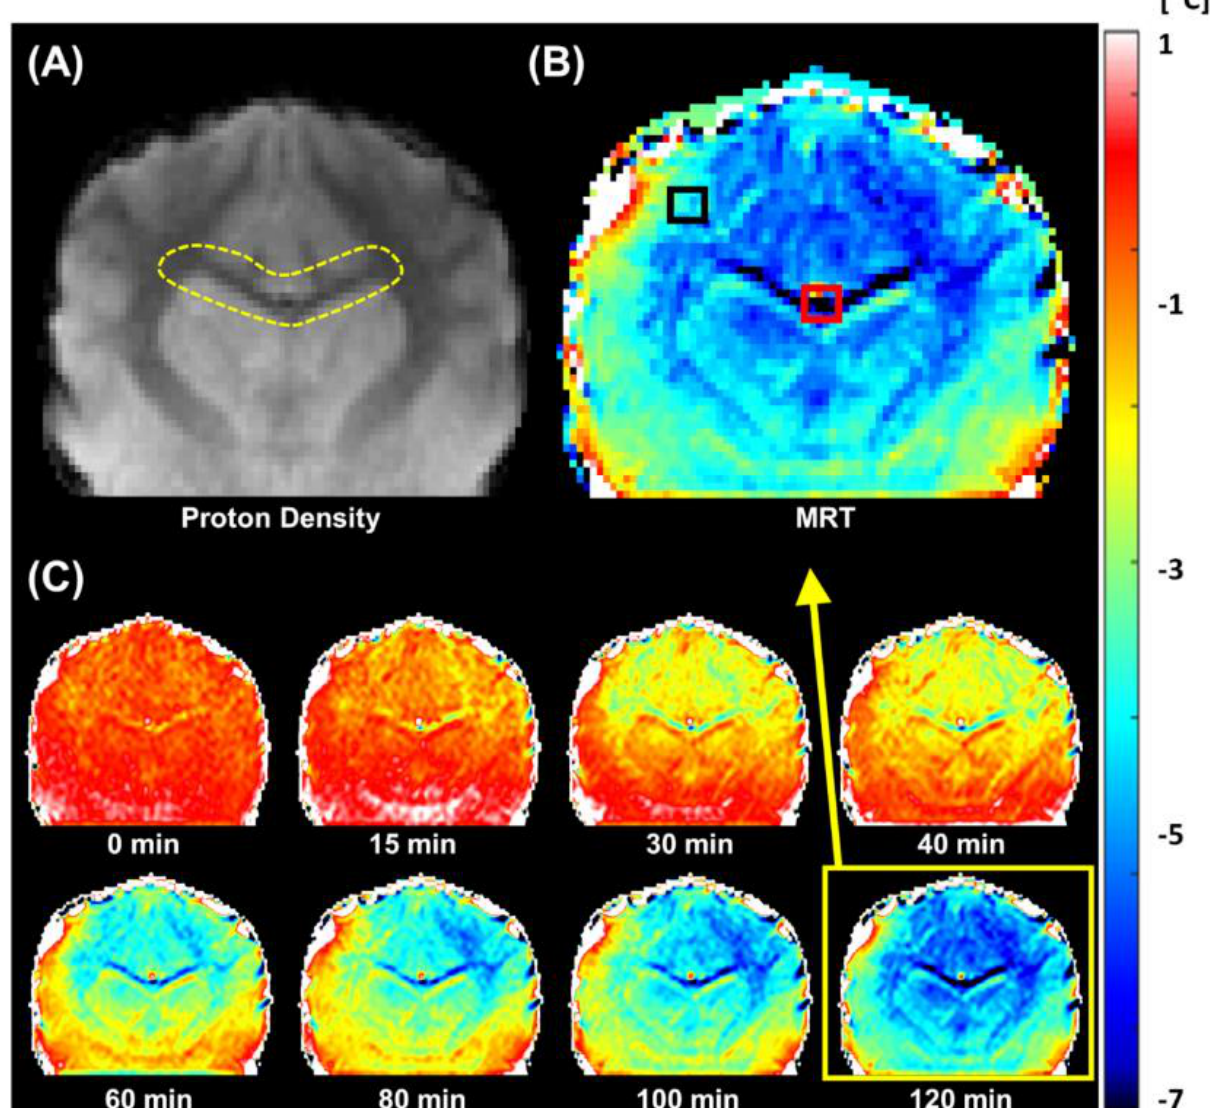
Figure 3. In vivo MR temperature images of canines under general anesthesia. ( A ) Axial MR magnitude image (yellow dashed region: corpus callosum). ( B ) MR temperature image. Corpus callosum (red box, contains white matter only) and cerebral cortex regions (black box, gray matter) of MR temperature image are indicated for temporal temperature changes in Figure 4. ( C ) Selected temporal MR temperature images during general anesthesia.